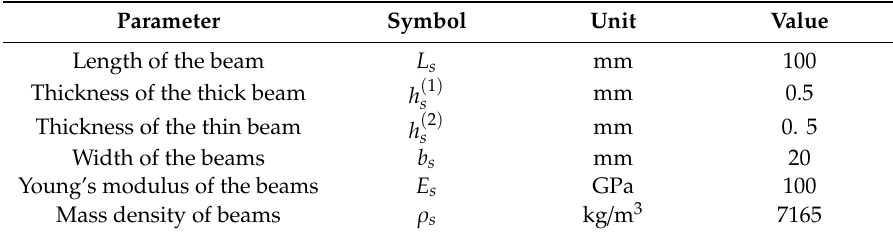
Table 4. Physical and geometrical parameter values of the sample structure.